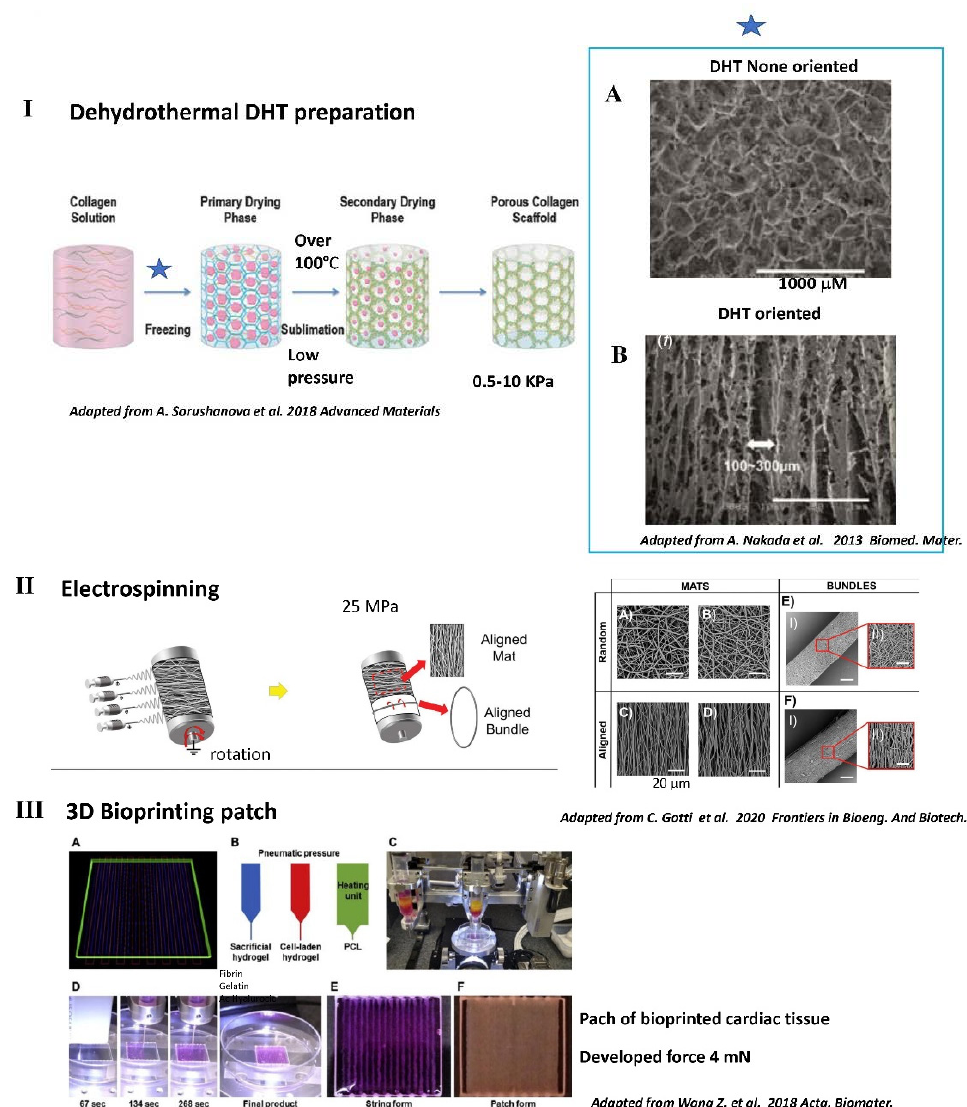
Figure 3. Classical methods for obtaining a 3D solid scaffold with collagen. The most commonly used methods are dehydrothermal treatment (DHT) (panel I ), electrospinning (panel II ) and 3D dehydrothermal treatment (DHT) (panel I ), electrospinning (panel II ) and 3D bioprinting (panel III ). The DHT